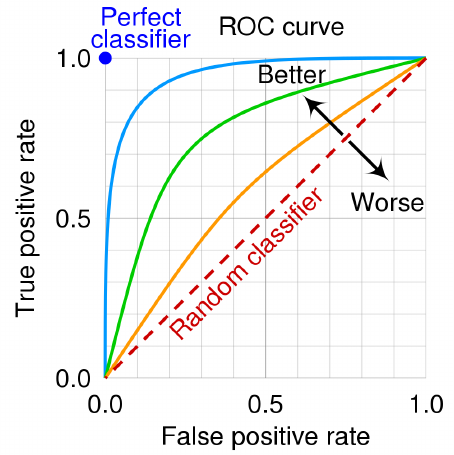
Figure 2. Receiver Operating Characteristic (ROC)